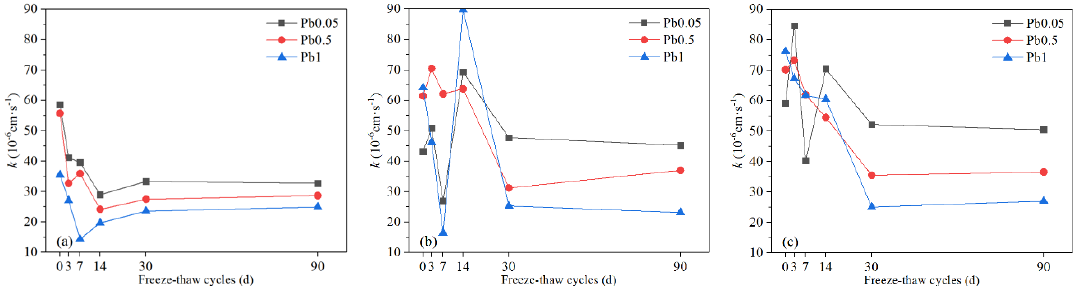
Figure 12. The k values of Pb-CSCSs with the same compound binder and di ff erent contaminant